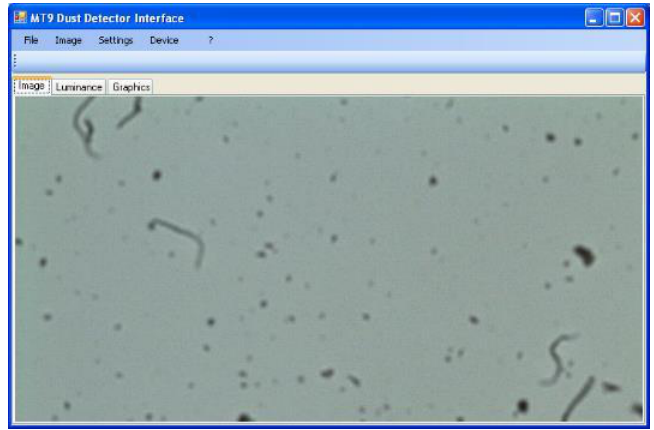
Figure 2. A screenshot of the MT9 Dust Detector Interface